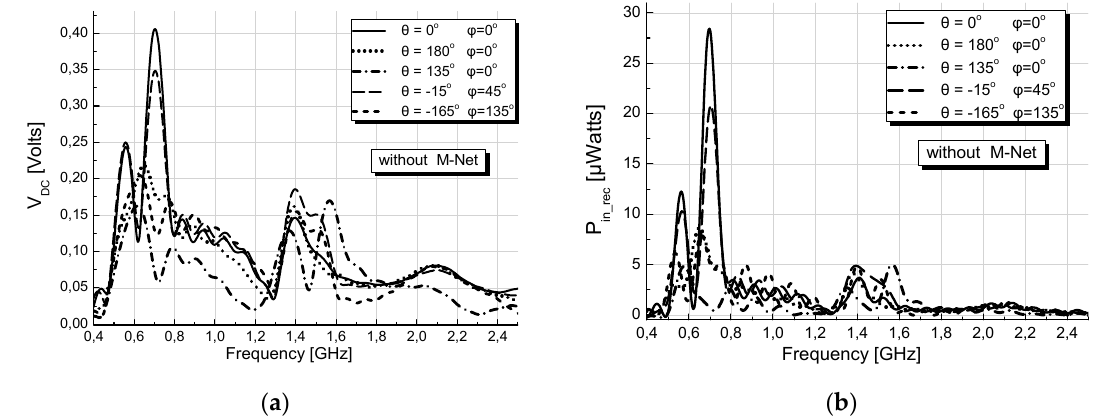
Figure 10. Results versus frequency for rec1 without any M-Net: ( a ) direct current (DC) voltage at the output of the rectifier, ( b ) power available at the input of the rectifier.